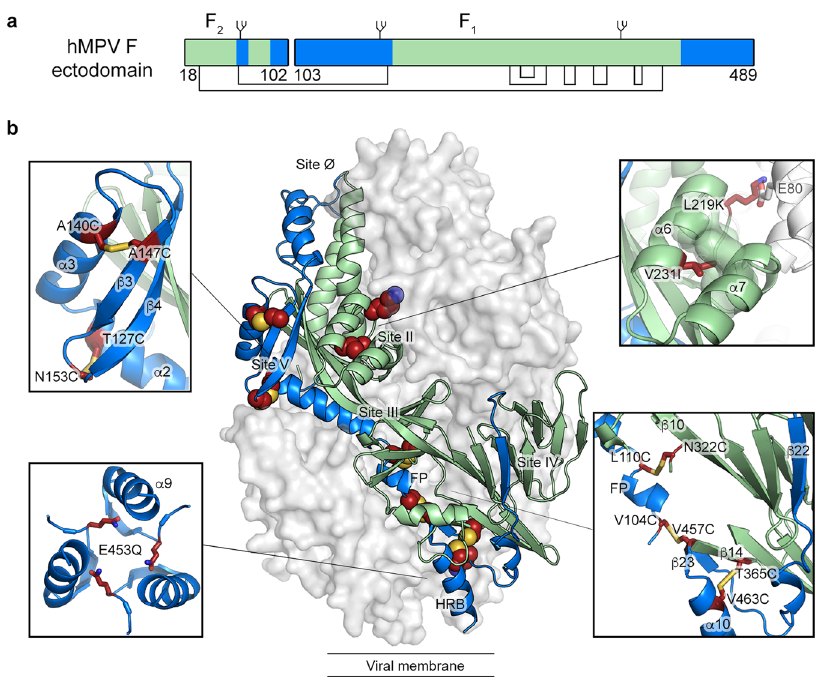
Fig. 1 Bene fi cial substitutions for hMPV F stabilization. a Schematic of the hMPV F ectodomain. Disul fi de bonds and N-linked glycosylation sites are highlighted. The residue numbers indicating the beginning and the end of the F1 and F2 subunits are shown. b Side view of the trimeric hMPV F ectodomain in a prefusion conformation (PDBID: 5WB0). One protomer is shown as a ribbon diagram, and the other two are shown as a white molecular surface. Insets highlight the position of select stabilizing substitutions. Side chains in each inset are shown as dark red sticks with sulfur atoms in yellow, nitrogen atoms in blue and oxygen atoms in red. In both panels, regions undergoing conformational changes during the pre-to-postfusion transition are colored blue and the regions remaining static are colored